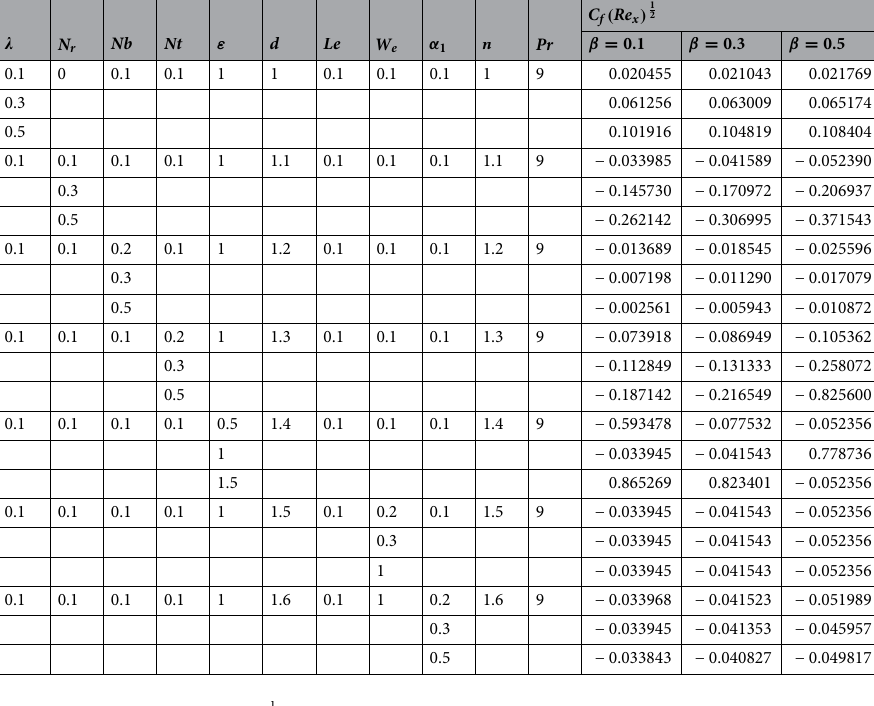
Table 1. Variation of C f ( Re x )